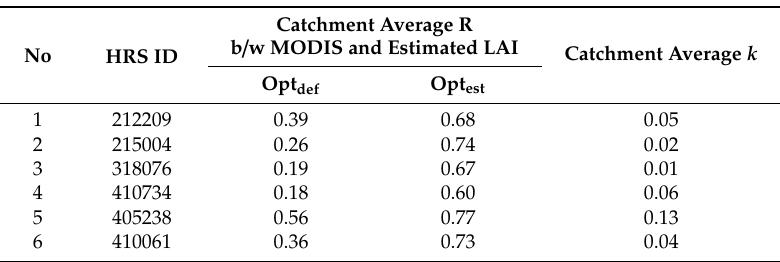
Table 5. Parameter Optimization Results over the Six Catchments Used for SM and ET Simulations.